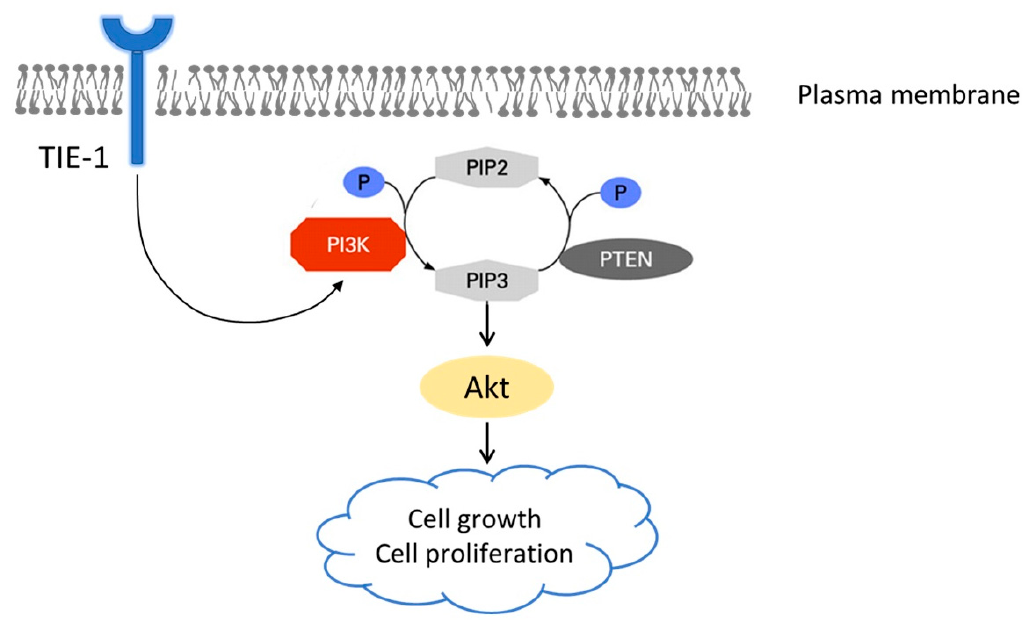
Figure 5. TIE-1 regulates PI3K expression and promotes PI3K-mediated cell proliferative phenotype. Proposed action mechanisms of TIE-1: high TIE-1 expression induces PI3K upregulation and PI3K-mediated cell proliferative phenotype.